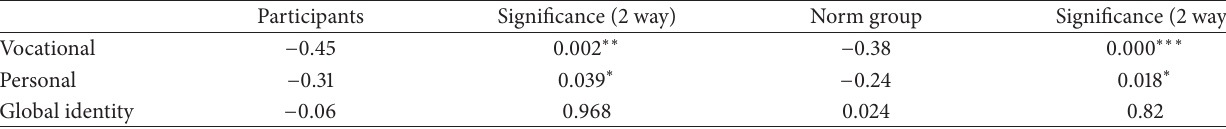
Table 5: The correlations between change in commitment strength and exploration in the same domain ( 𝑛 = 45